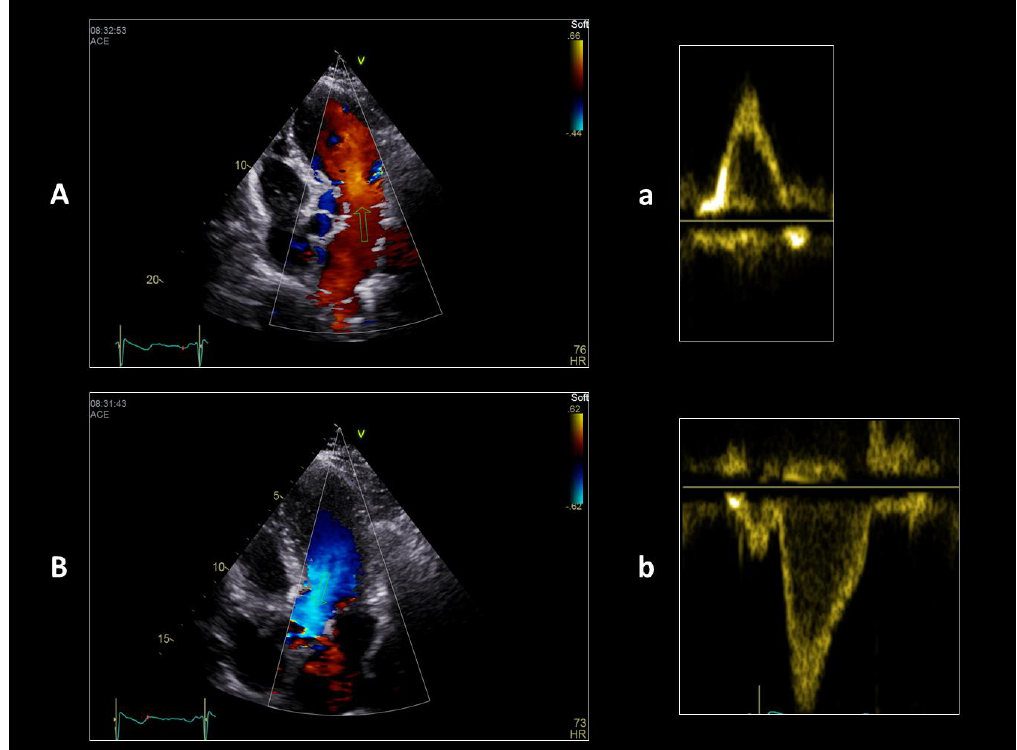
Figure 3. Echo color Doppler ( A , B ) and Pulsed Doppler ( a , b ) study of diastolic ( A , a ) and systolic ( B , b ) intra-ventricular flows in a healthy volunteer. The color homogeneity and the black areas under the pulsed curves indicate a laminar flow.